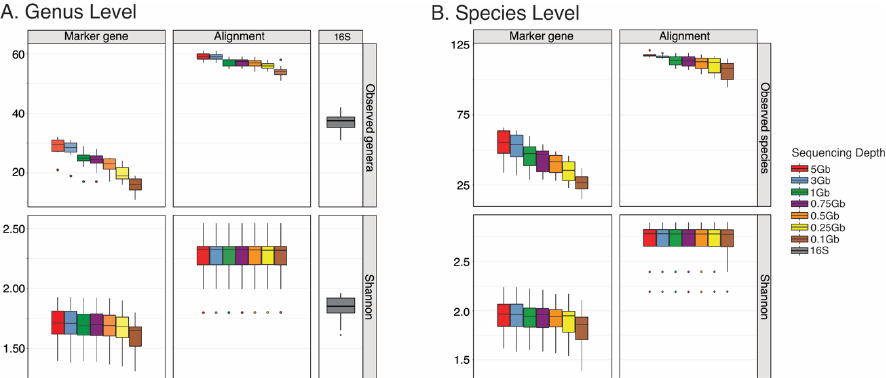
Figure 1. Boxplots of the α -diversity of ten stool samples from healthy subjects at various sequencing depths, including 5 Gb (16.67 M reads), 3 Gb (10.00 M reads), 1 Gb (3.00 M reads), 0.75 Gb 2.50 M reads), 0.5 Gb (1.65 M reads), 0.25 Gb (0.85 M reads), and 0.1 Gb (0.34 M reads). The 16S sequencing analysis at the genus level was performed for comparison. ( A ) Number of observed genera and Shannon diversity at the genus level for the marker gene-mapping and alignment methods. ( B ) Number of observed species and Shannon diversity at the species level for the marker gene-mapping and alignment methods. Outliers are